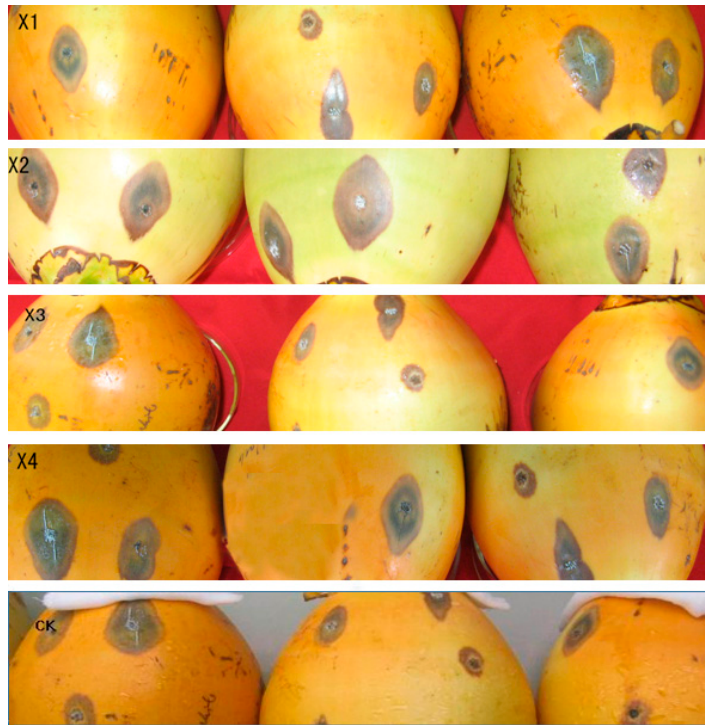
Figure 5. Pathogenicity detection of the transformants. Symptoms of coconut stem-bleeding disease on coconut fruits after wound-inoculating 1.5 × 10 5 spores · mL − 1 suspension of transformants ( X1 – X4 ), respectively, for 3 days. CK: wild-type strain X-3314 was used as a control.